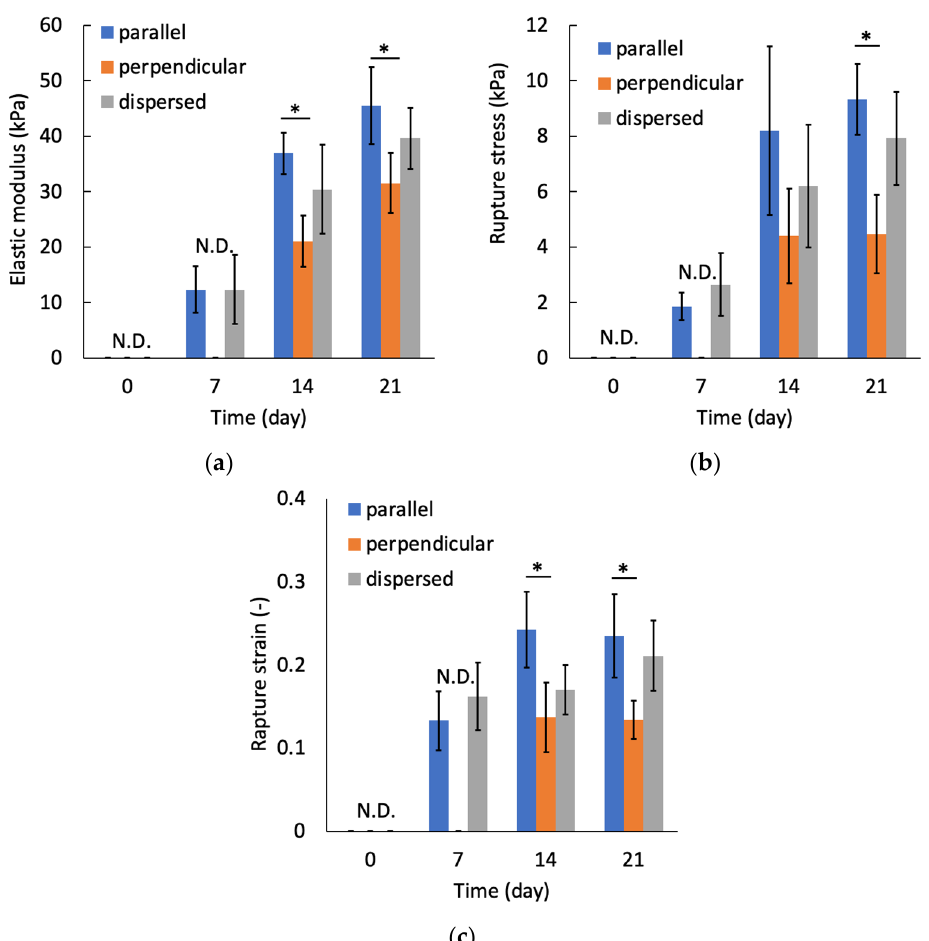
Figure 13. Representative stress–strain diagram of the agarose gel sheet-laminated construct con- taining chondrocytes cultured for 21 days. Black arrows indicate the rupture point of each specimen.